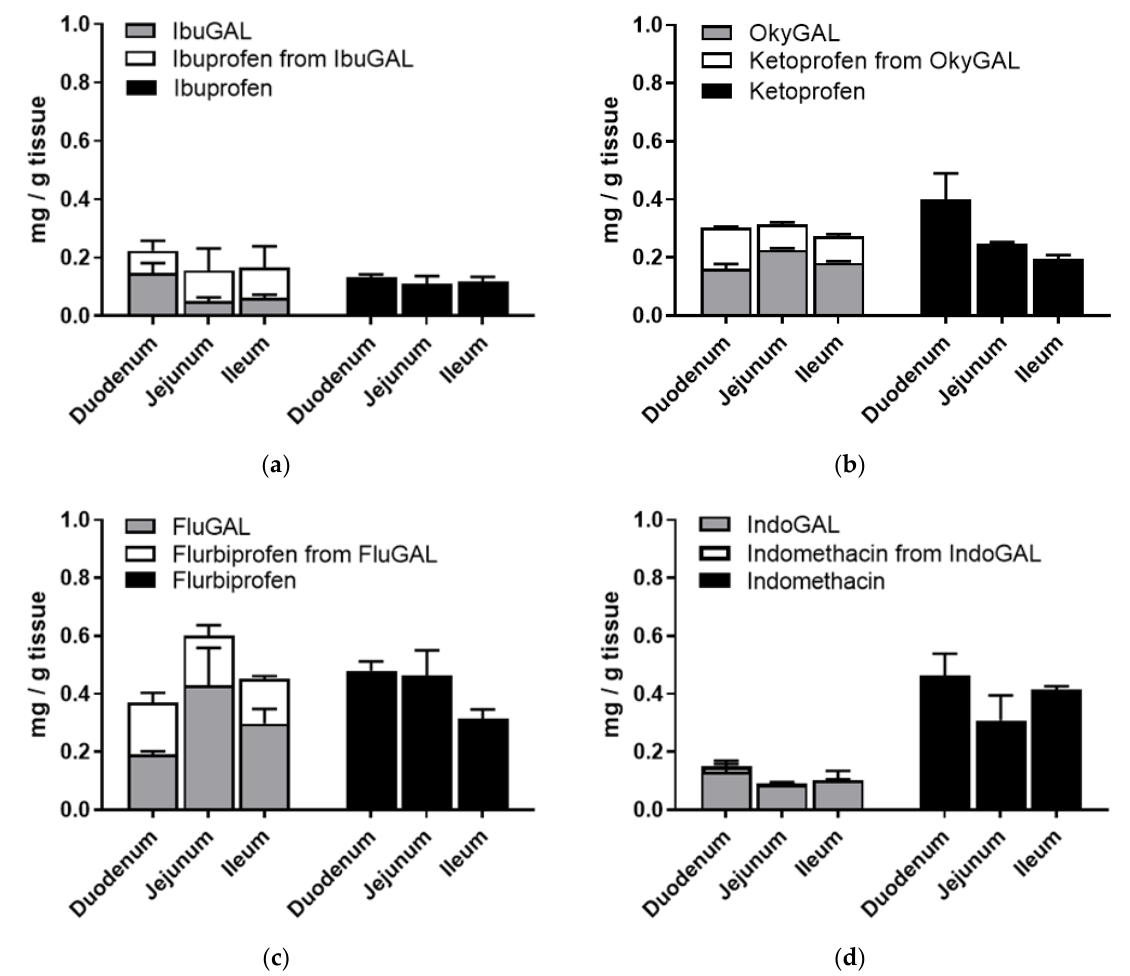
Figure 3. ( a–d ) Ex vivo intestinal permeation. Tissue accumulation of parent drugs ( a ) ibuprofen,